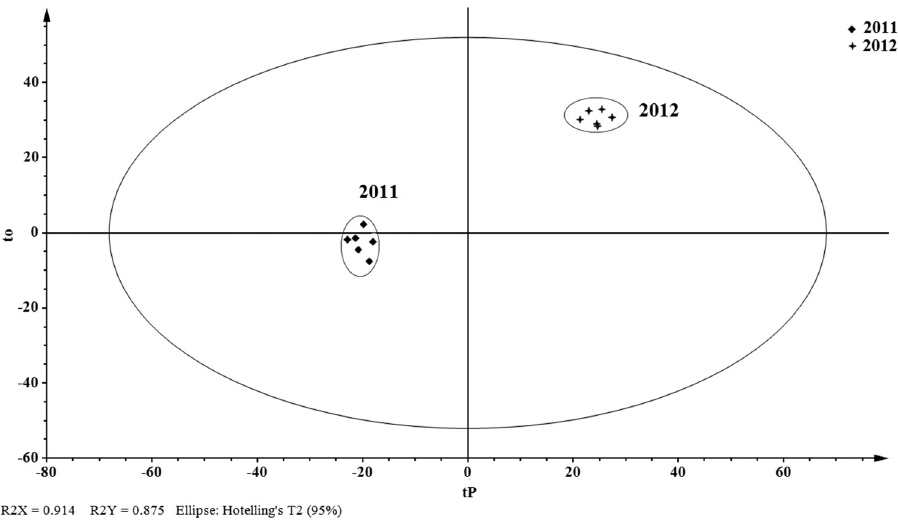
Figure 19: OPLS - DA score plot chart from 1 H NMR spectra of 2011 and 2012 vintage Cabernet Sauvignon wines.